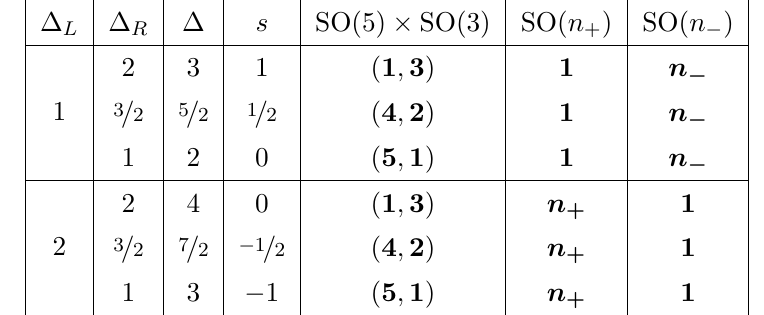
Table 17. Mass spectrum for the OSp(4 (cid:3) j 4) solution for the chiral embedding (2.21b) with gauge group SO(5 ; n + ) SO(3 ; n (cid:2) (cid:0)